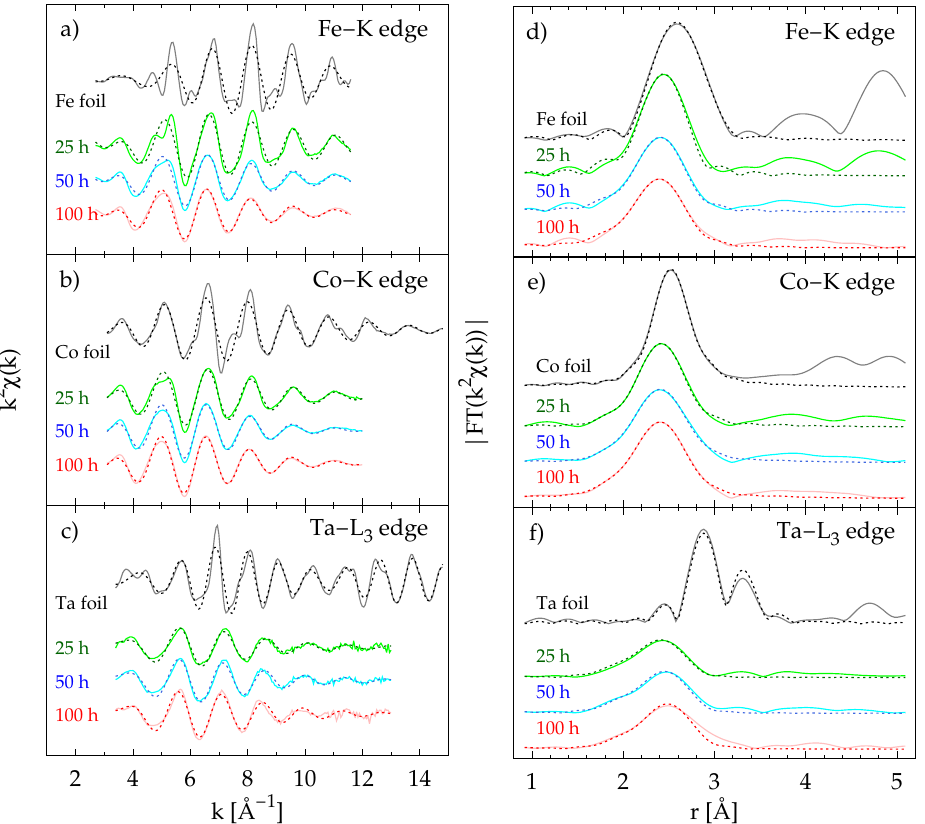
Figure 8. EXAFS signals k 2 χ ( k ) in k -space ( a – c ) and corresponding magnitudes of its Fourier transforms in r -space ( d – f ) as measured above Fe-K, Co-K and Ta-L 3 edges for the alloy CoFeTaB after 25, 50 and 100h of mechanical alloying. The solid lines correspond to experimental data, whereas dashed lines correspond to fitting curves based on the quick first shell model. Additionally, signals from reference foils are presented. For better clarity, curves are vertically